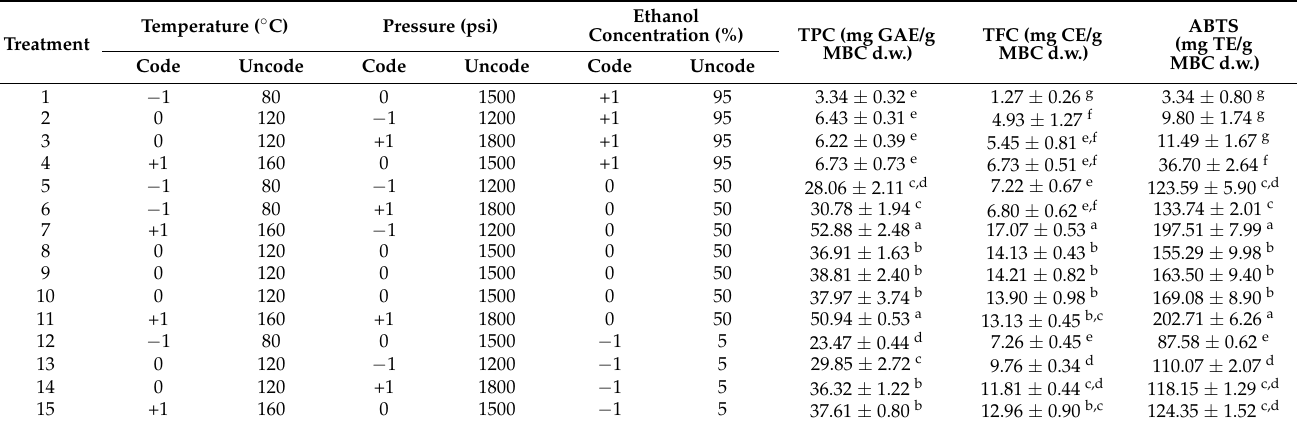
Table 1. Coded and uncoded levels of independent variables in experimental design, TPC, TFC and ABTS from the MBC